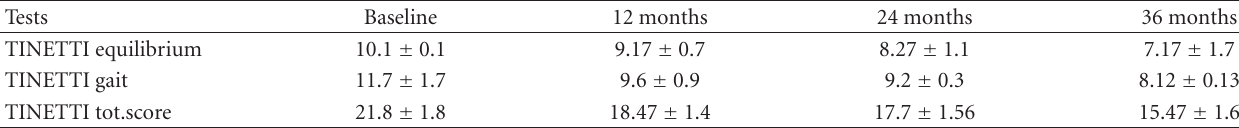
Table 5: Gait tests results in the patients observed during